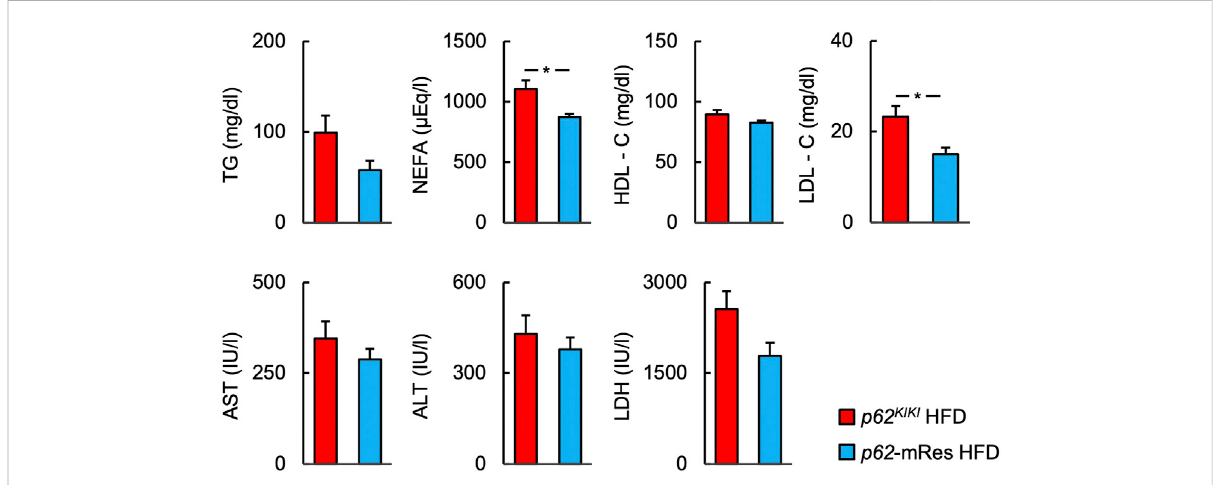
p62 in muscle reduces the serum concentrations of NEFA and LDL-C. Serum biochemistry [the triglyceride (TG), non-esteri fi ed fatty acids (NEFA), high-density lipoprotein-cholesterol (HDL-C), and low-density lipoprotein-cholesterol (LDL-C) concentrations; and the aspartate aminotransferase(AST),alanineaminotransferase(ALT), andlactatedehydrogenase(LDH)activities]inthefedstate ( n =6/group).Valuesaremean± SEM. * p < 0.05 (unpaired t -test).